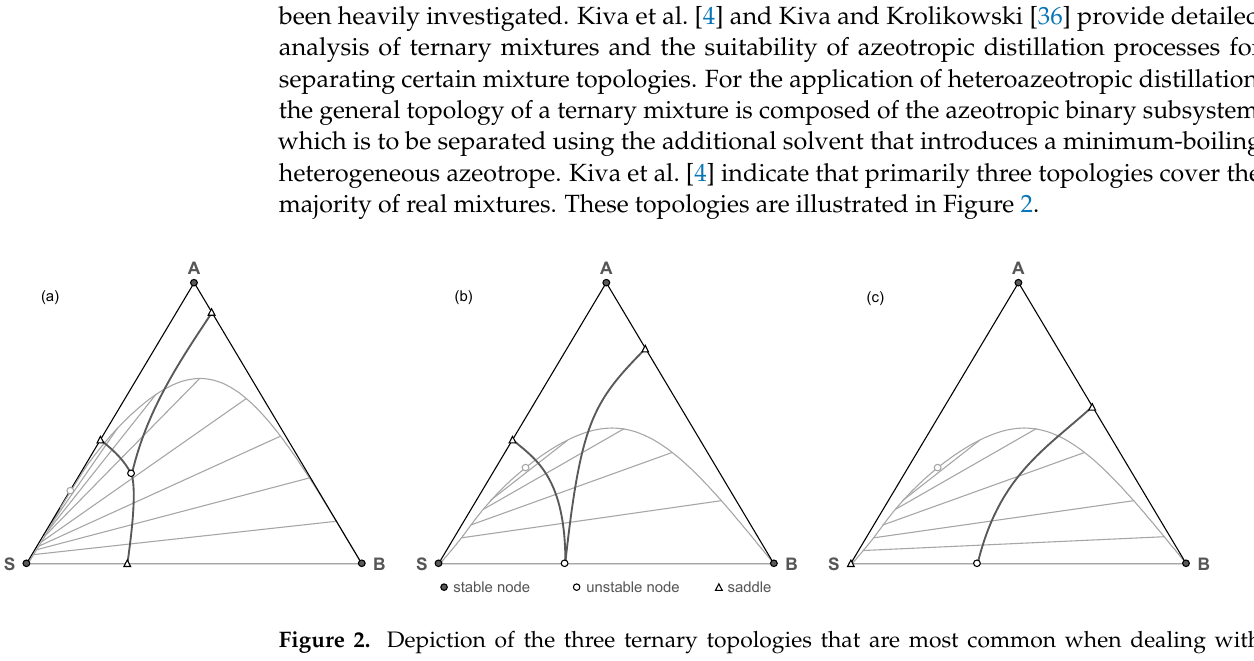
Figure 2. Depiction of the three ternary topologies that are most common when dealing with heteroazeotropic distillation, comprising four ( a ), three ( b ), and two ( c )